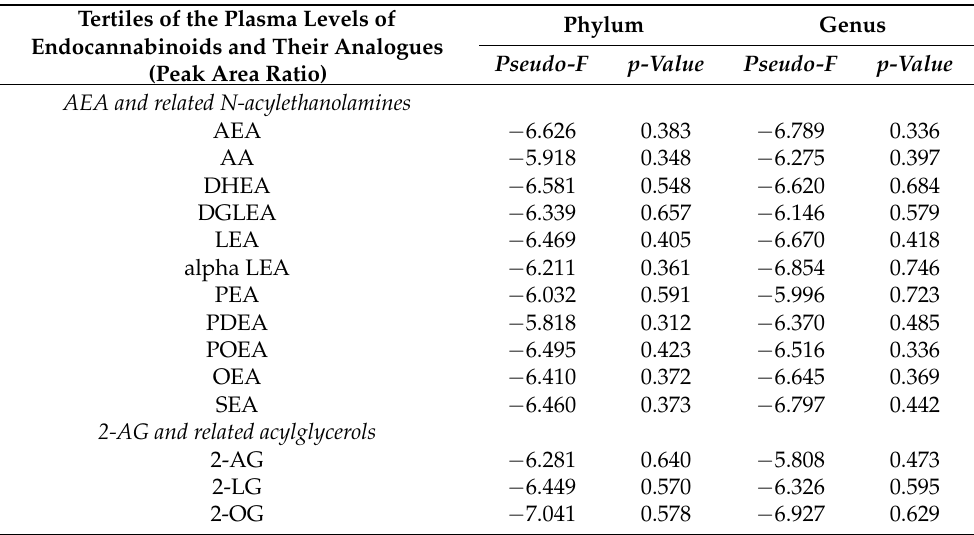
Table 2. Beta diversity across different tertiles of endocannabinoids and their analogues at phylum and genus taxonomic levels. Tertiles of the Plasma Levels of Phylum Genus Endocannabinoids and Their Analogues Pseudo-F p-Value Pseudo-F p-Value (Peak Area Ratio)